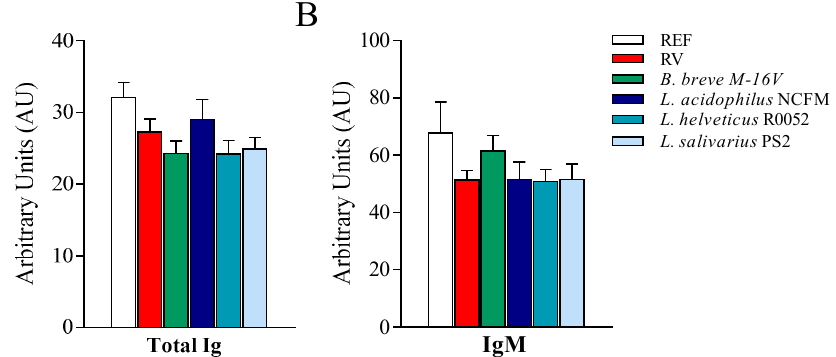
Figure 5. Specific anti-RV immunoglobulins (Ig). The quantification of anti-rotavirus (RV) Ig in plasma was performed by ELISA at the end of the study (day 14). The relative amount of ( A ) total and ( B ) IgM anti-RV Ig are displayed for the different experimental groups. Results are expressed as mean ± S.E.M. ( n = 24/group) of arbitrary units (AUs). The highest dilution of the standard (pooled sera) corresponded to 1 AU. REF: reference; B .: Bifidobacterium ; L .: Lactobacillus .